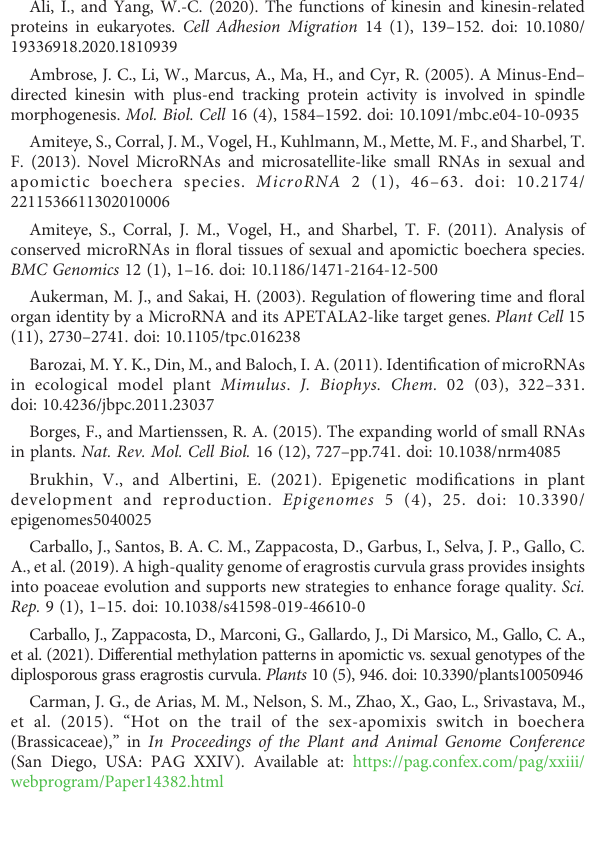
SUPPLEMENTARY FIGURE 1 Heatmap of the clustering of samples based on distance matrix. Heatmap showing the distance matrix obtained on logarithm transformed counts, showing similarities and dissimilarities between the seven samples DW-1, DW-2, DW-3, T.USDA-1, T.USDA-2, OTA-1, OTA-2. In the color scale, red and bluerepresent moreandlessdistance betweensamples, respectively. SUPPLEMENTARY FIGURE 2 Principal component analysis plot. PCA plot showing the similarity within samples with the same reproductive behavior. The variance of principal components PC1andPC2arerepresentedinthexandyaxis,respectively. SUPPLEMENTARY FIGURE 3 Alignment between miRNAs and their targeted transcripts. miRNA - target interaction between. (A) Ecu-miRNA_novel_1 and kinesin-like protein KIN-14D, (B) Ecu-miRNA_novel_2 and patatin-like protein 2, (C) Ecu- miR156c and Growth-regulating factor 8, (D) Ecu-miR398 and DREB2A, (E) Ecu-miR166 and DNA-directed RNA polymerase II subunit RPB1, (F) Ecu-miR2275c and Transcription factor GAMYB, and (G) Ecu-miR156d and Squamosa-promoter binding protein-like protein 13 (Table